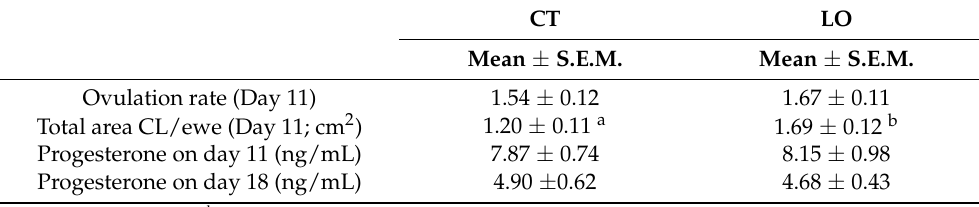
Table 6. Fertility indexes after artificial insemination in Sarda dairy ewes non-supplemented (CT) and supplemented with bypass linseed oil (LO).